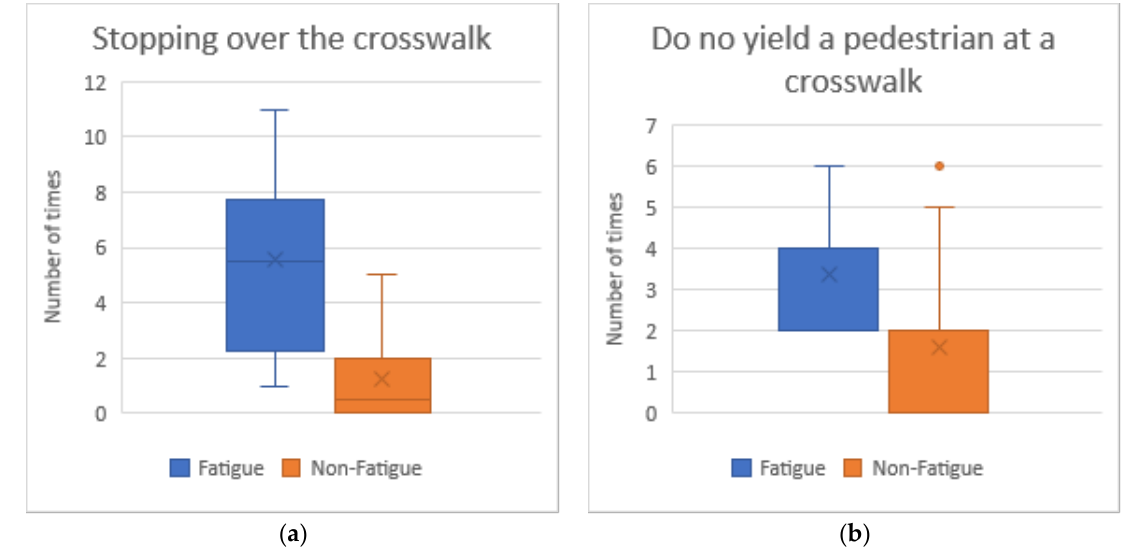
Figure 6. Average number of traffic rules broken grouped by tiredness level: ( a ) Stopping over the crosswalk; and ( b ) Do not yield to a pedestrian at a crosswalk.